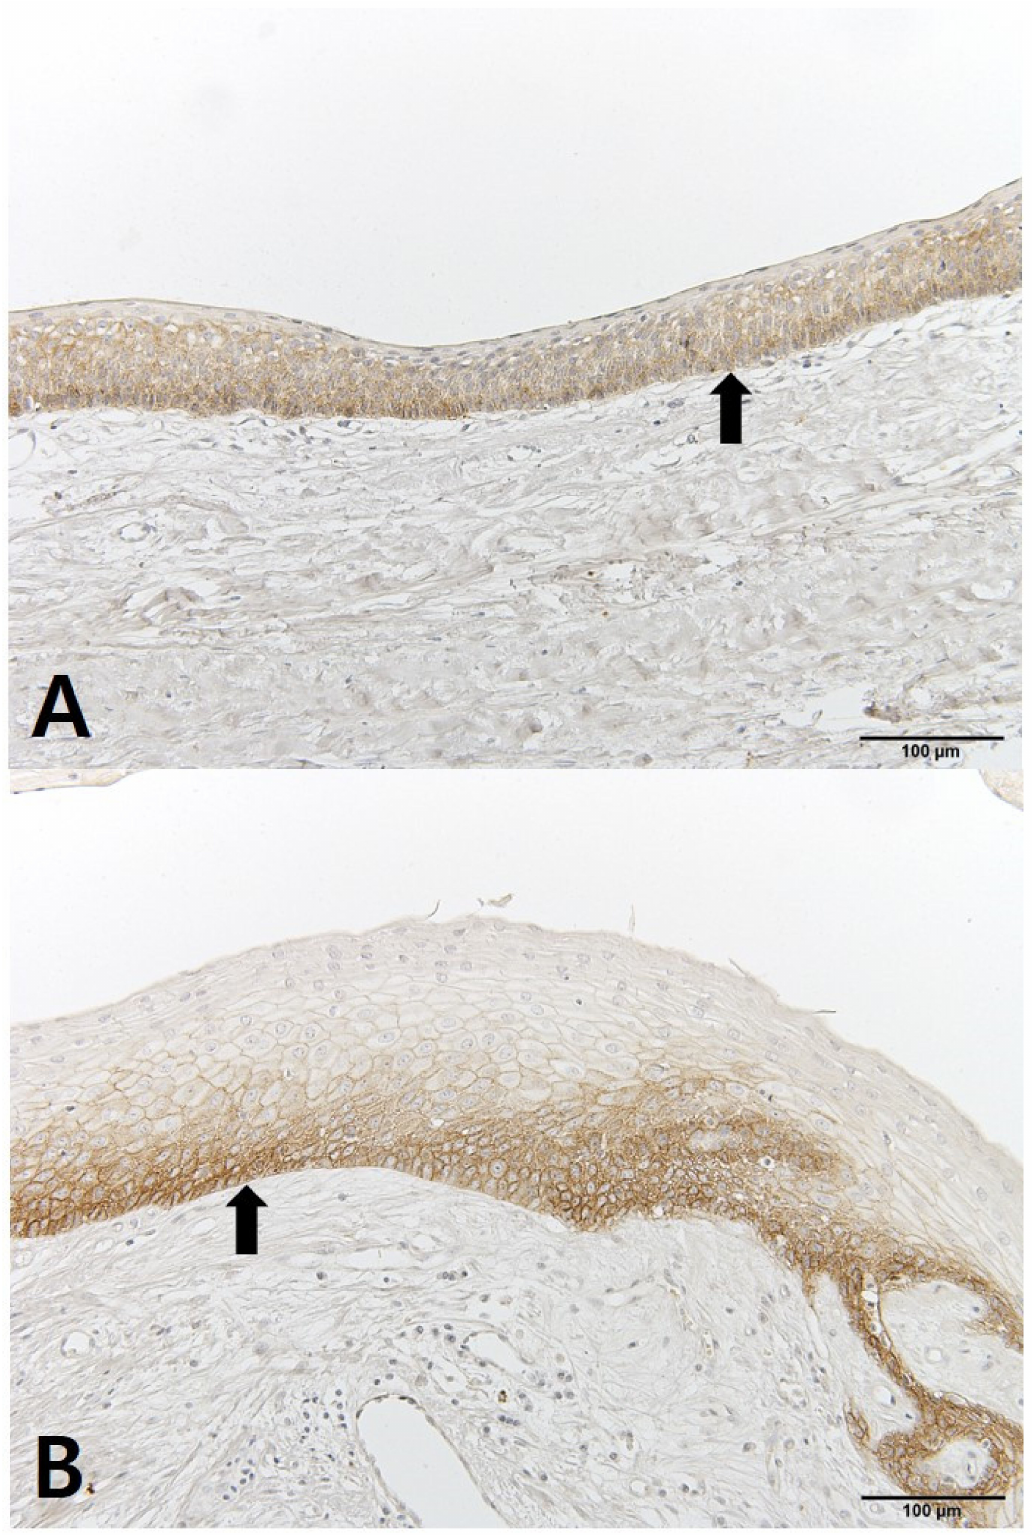
Figure 5. IHC staining of epidermal growth factor receptor (EGFR): ( A ) tissue obtained at decompression; ( B ) tissue obtained